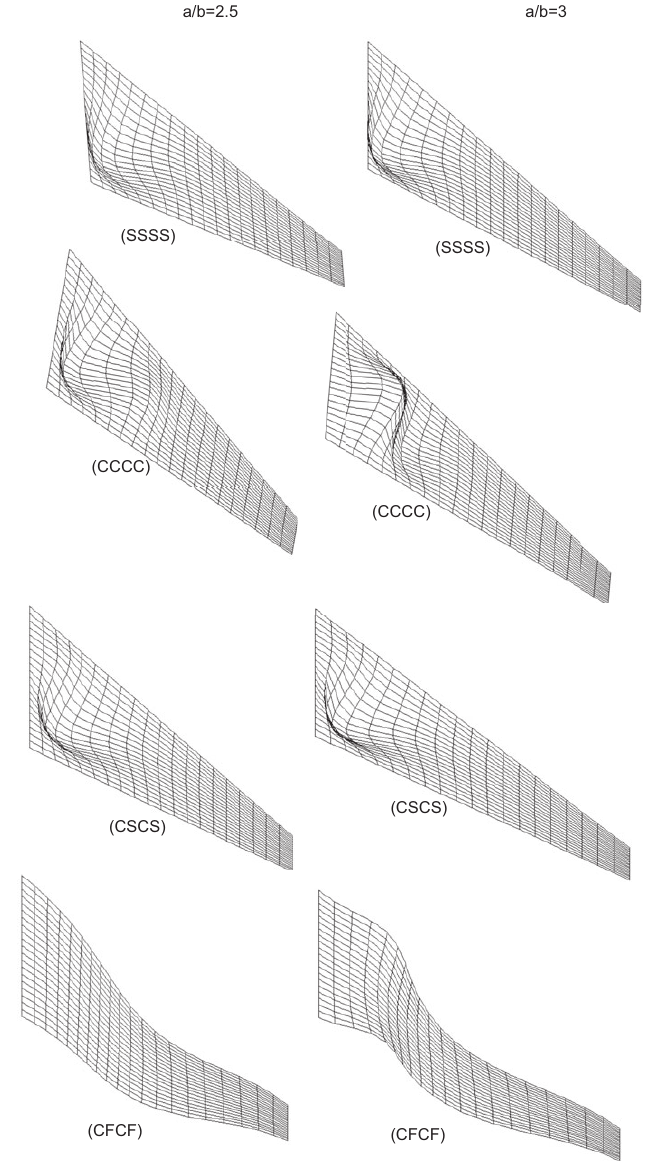
Figure 4 Mode shapes for aspect ratios and boundary conditions for trapezoidal laminated plates.